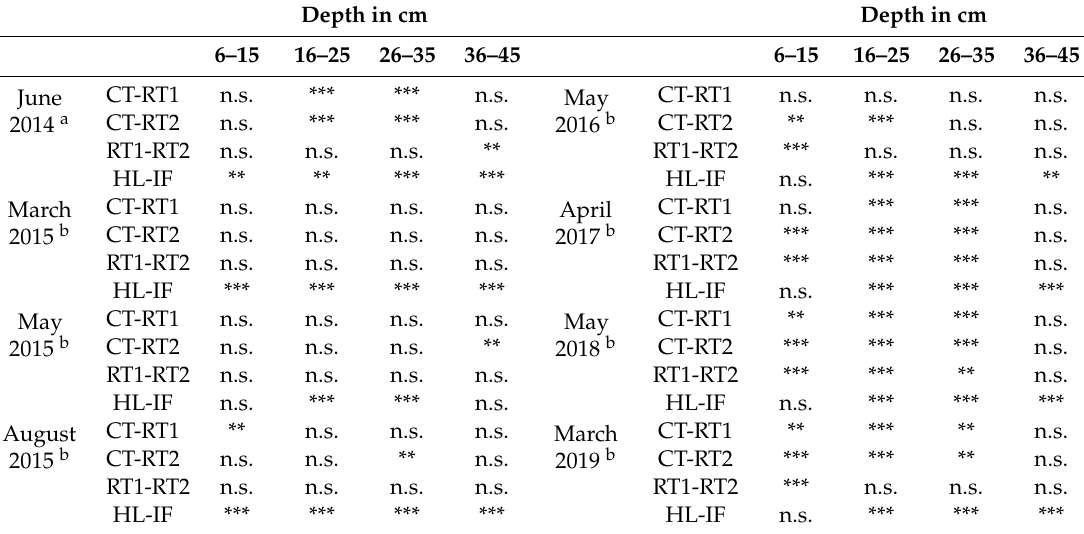
Table 2. Significance of di ff erences in mean penetration resistance comparing conventional tillage, reduced tillage practices and the headlands, subdivided into 10-cm depth